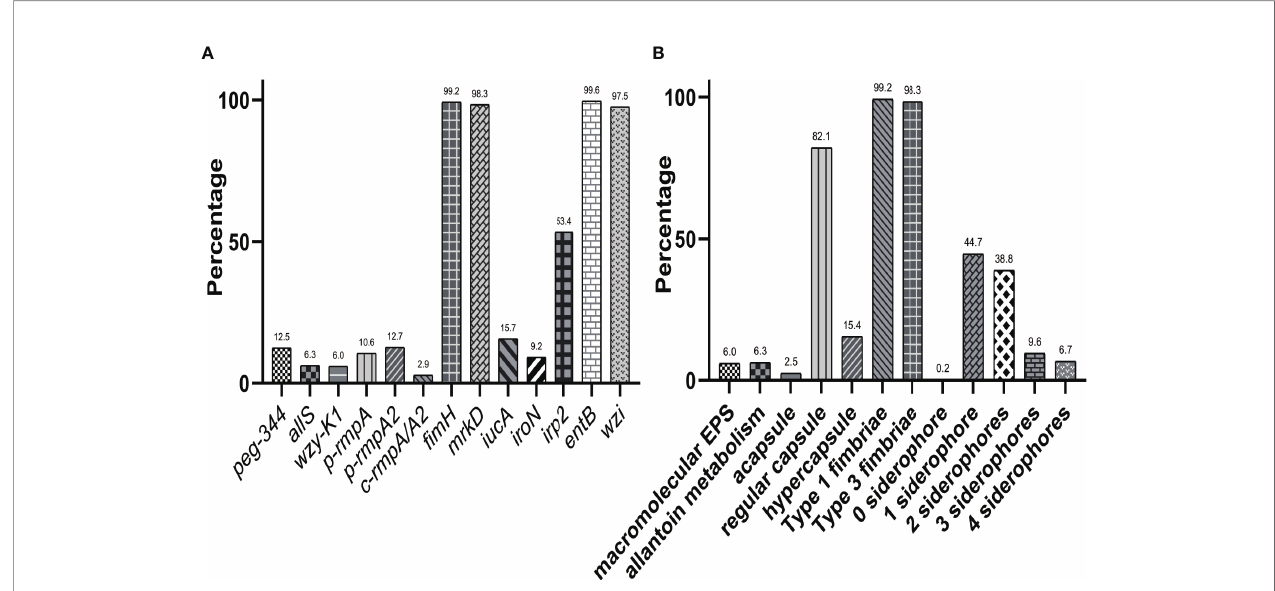
FIGURE 1 | Distributions of virulence genes and factors in K. pneumoniae . (A) Distribution of 13 virulence genes in 521 K . pneumoniae strains. (B) Distribution of virulence factors in 521 K. pneumoniae